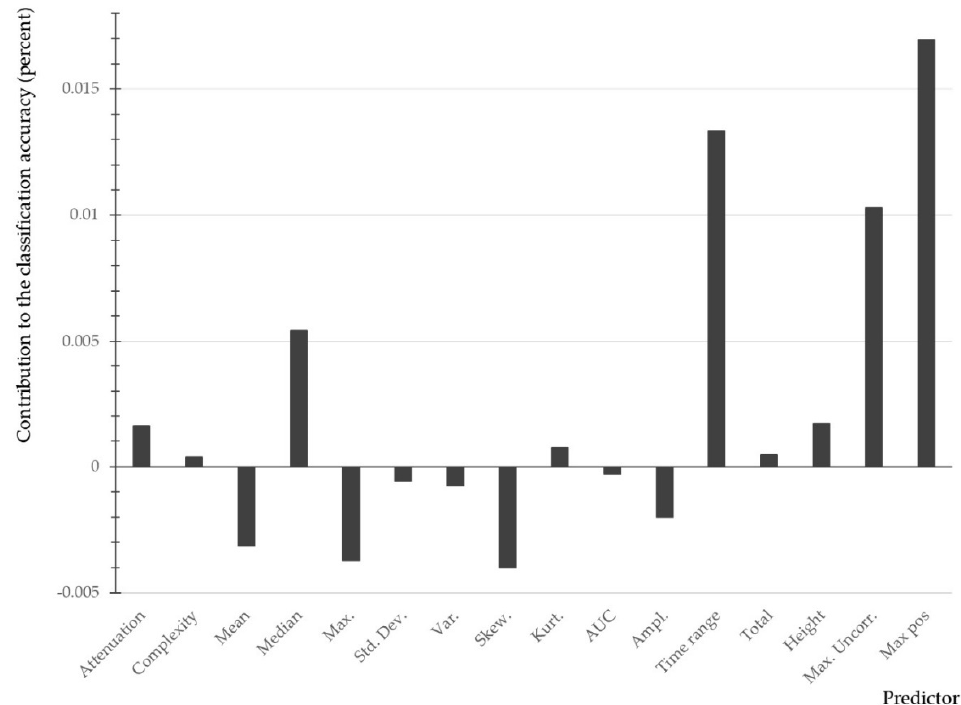
Figure 8. Predictors’ contribution to the green waveform features’ classification accuracy (in fraction of accuracy).